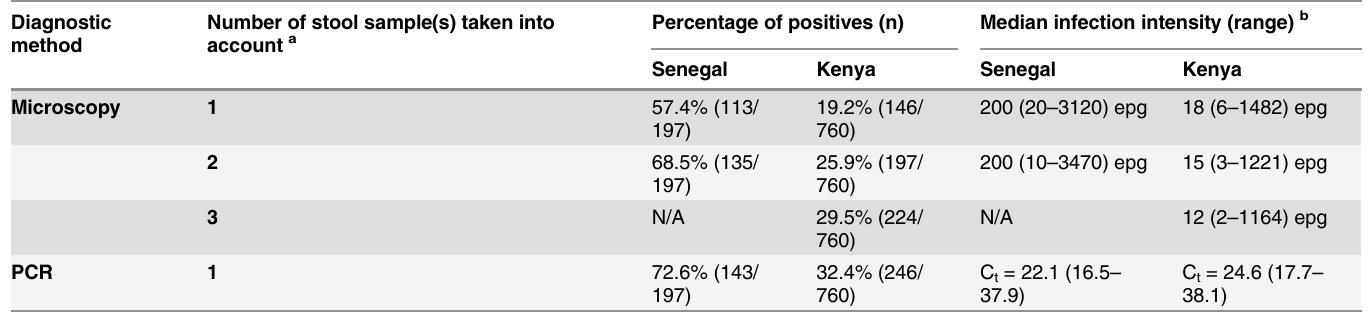
Table 1. Percentages of S . mansoni -positives and infection intensities: Microscopy versus PCR. Diagnostic method